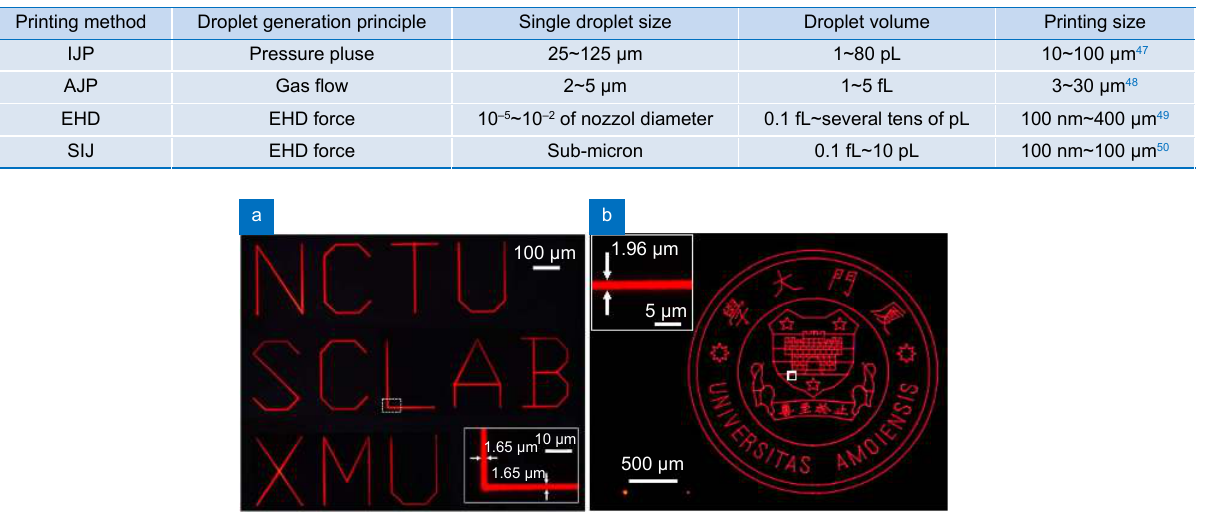
Fig. 6 | Fluorescence images of ( a ) NCTU and ( b ) logo of XMU printed by SIJ printing. Figure reproduced with permission from: (a) 15 , Optica Pub- lishing